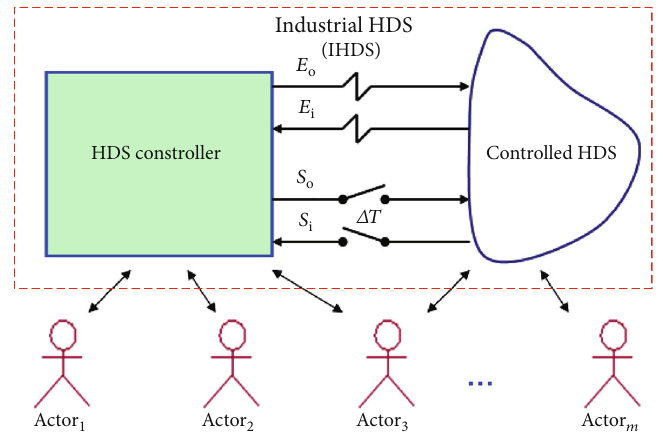
Figure 2: Block diagram of an industrial Hybrid Dynamic System (IHDS).